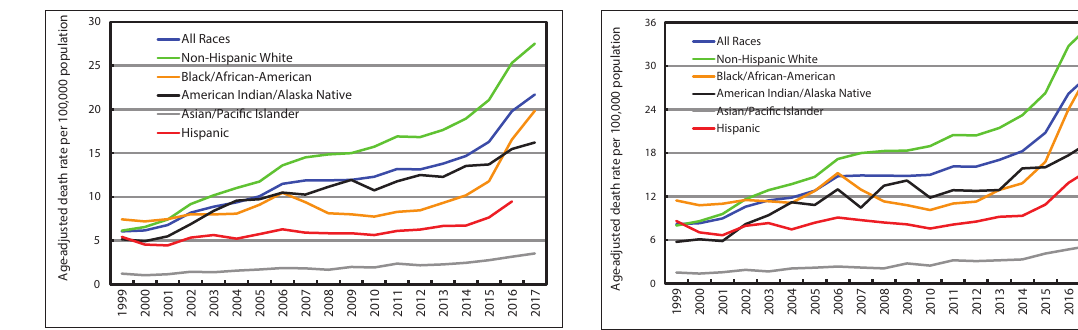
Figure 2: Racial/Ethnic Trends in Drug Overdose Mortality, Both Sexes, United States, 1999-2017 Source: Data derived the National Vital Statistics System, Nation - al Mortality Database.